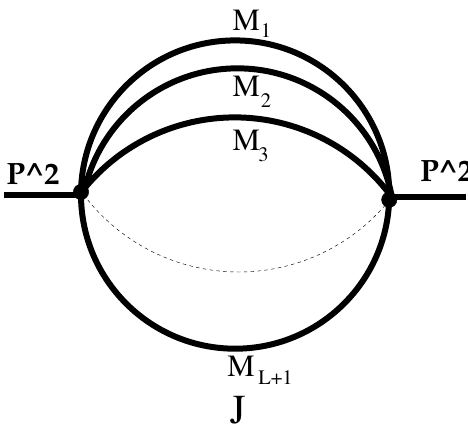
Figure 1 . L -loop sunrise